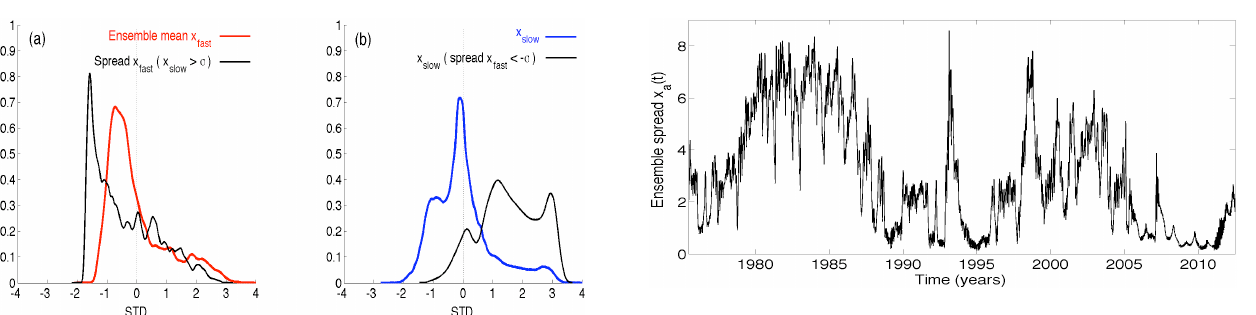
Fig. 4. (a) Pdf for the x fast anomalies from the interactive ensemble as a function of its standard deviation (STD) around the mean: en- semble mean in red and conditional ensemble spread – when x slow is greater than one standard deviation ( σ ) of the slow model anoma- lies – in black; (b) Pdf for the x slow anomalies as a function of its standard deviation (blue) and conditional x slow – when spread of x fast is less than one standard deviation ( σ ) of the fast model spread – in black.